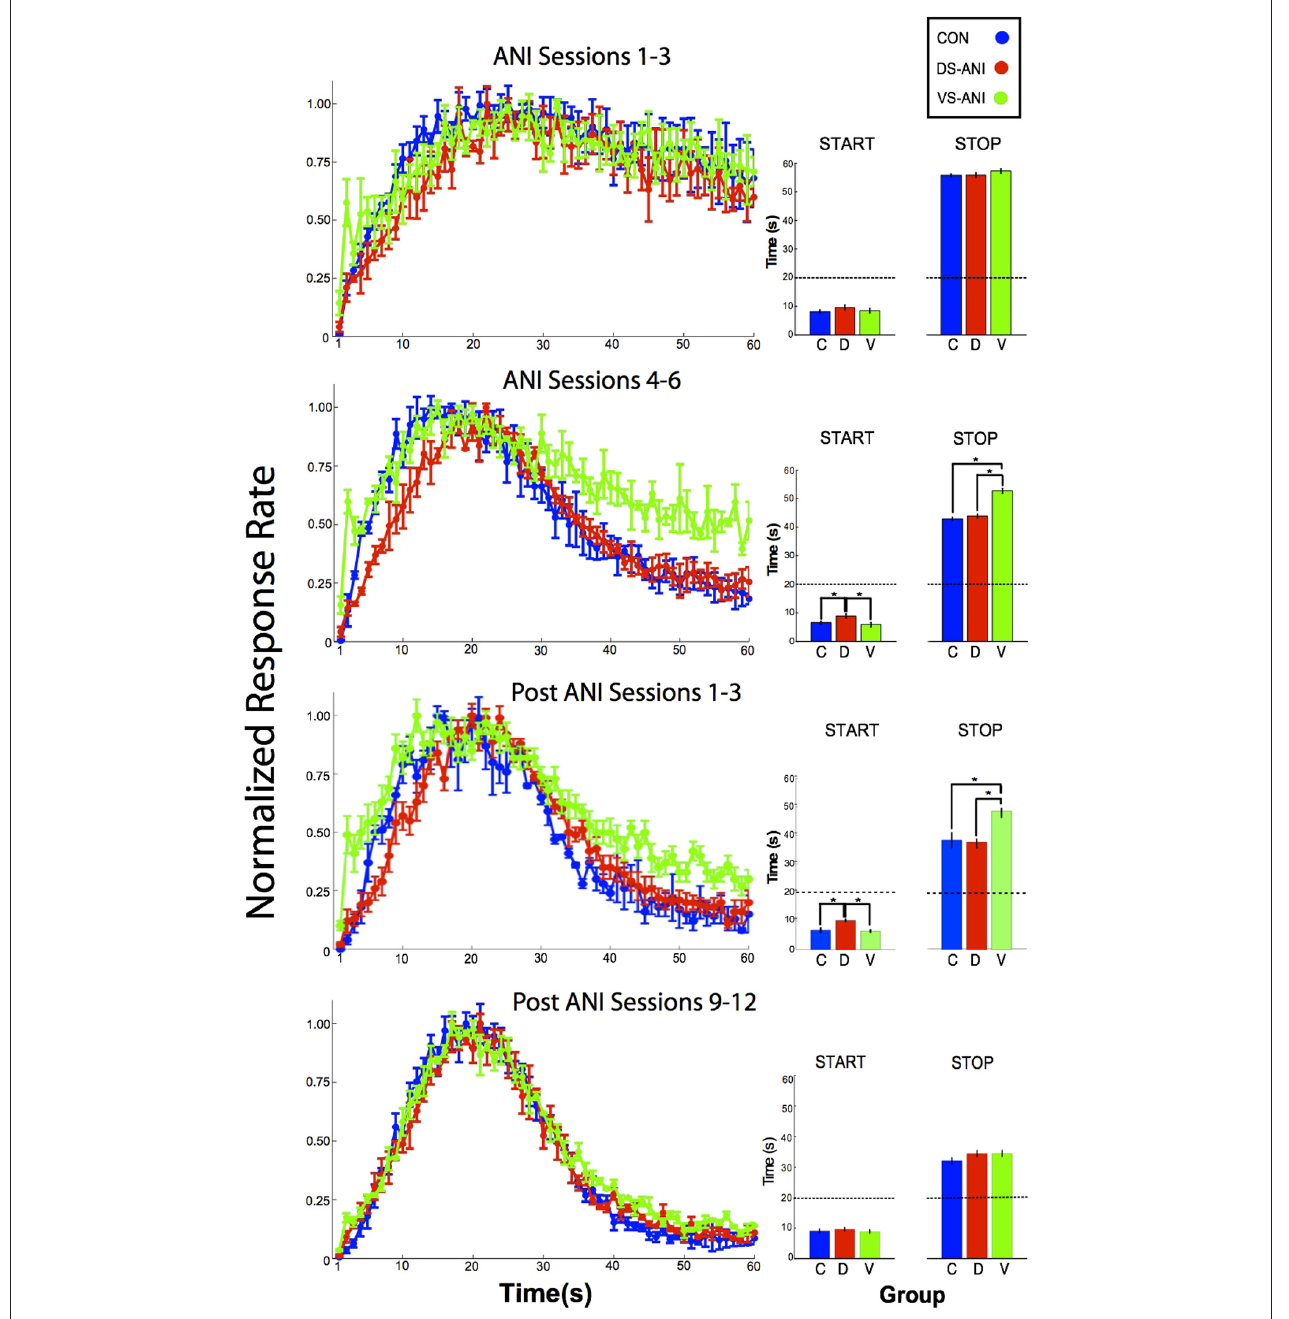
FIGURE 2 | Normalized mean ( ± SEM) peak functions (left column) for CON (blue), DS-ANI (red) and VS-ANI (green) treatment groups during four phases of the experiment: (A) ANI Sessions 1–3, (B) ANI Sessions 4–6, (C) post-ANI Sessions 1–3, and (D) post-ANI Sessions 12–14. Insets (right column) are included for each peak function to describe